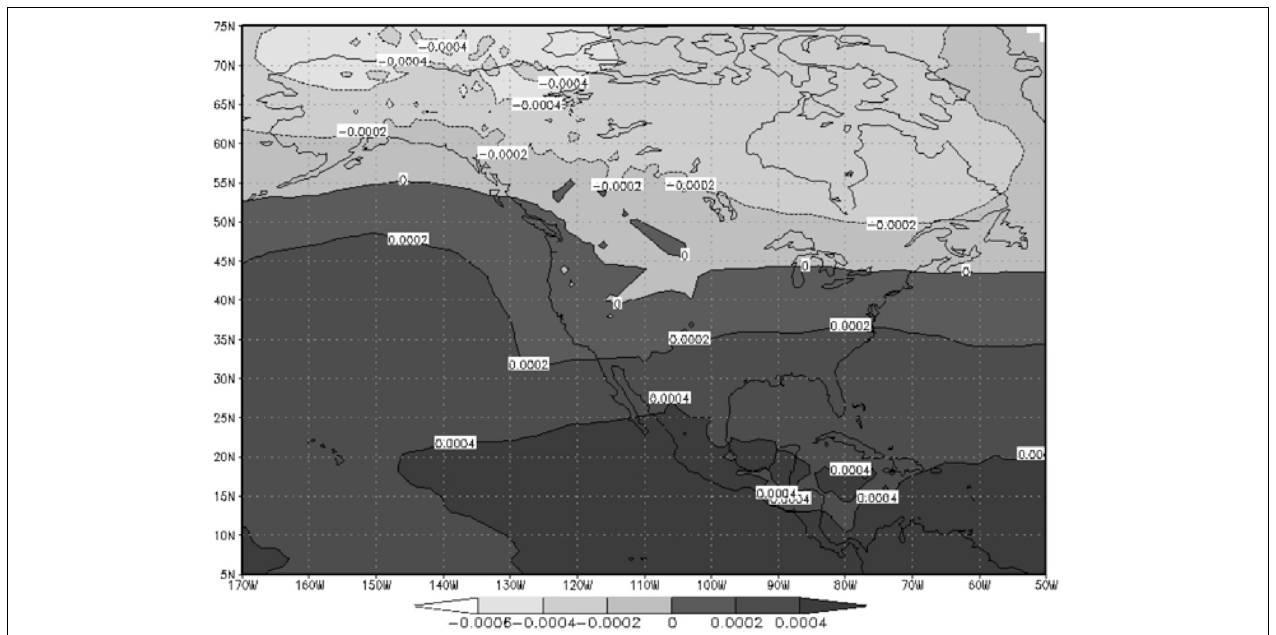
FIGURE 8 | Change of static stability (K hPa − 1 ) between 850 and 500hPa for the NH winter (2080–2089) conditions minus (1980–1989) conditions.